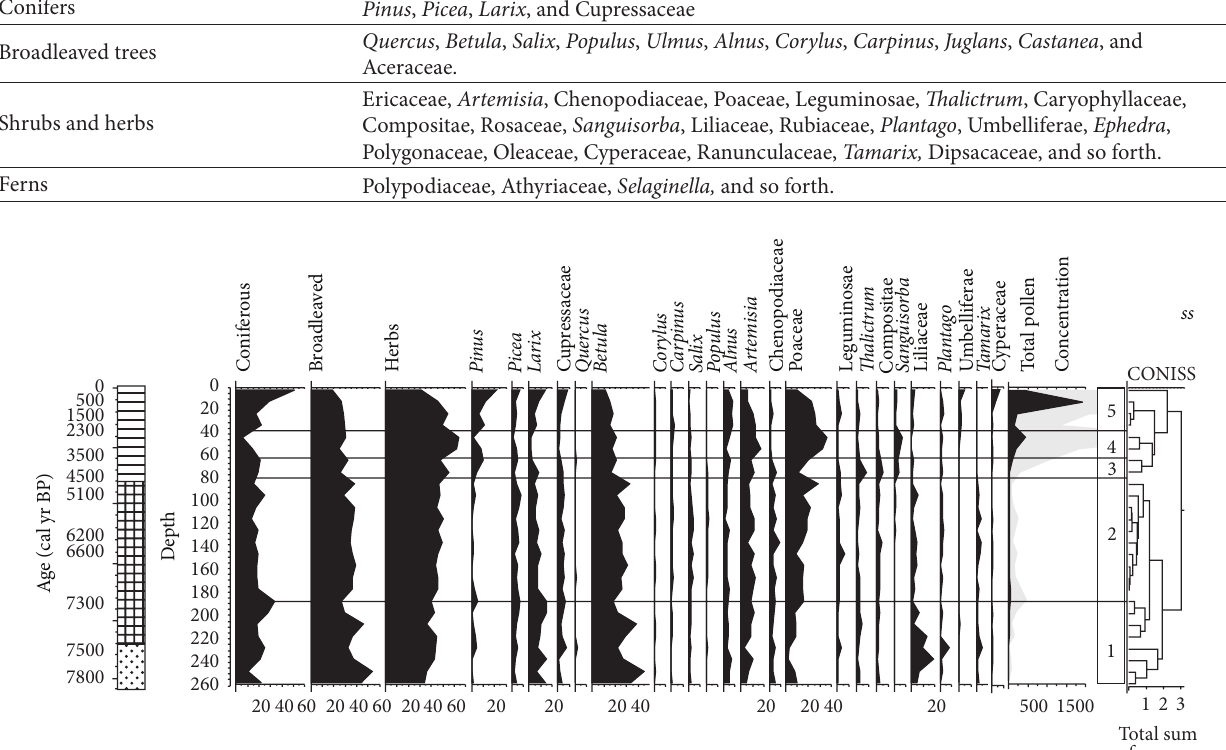
were drawn on a two-dimensional ordination map (Figure 4). the plane composed of the first and second principal